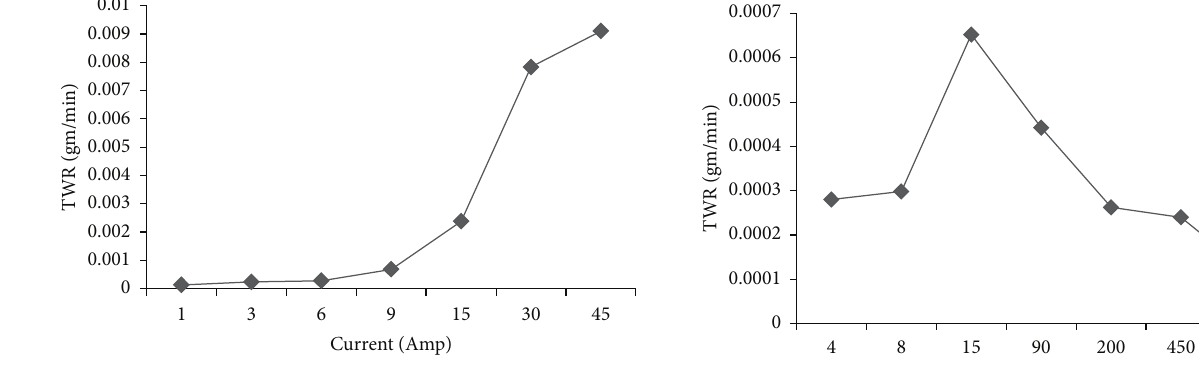
Figure13:InfluenceofcurrentonTWRatconstantgapvoltage60 V, pulse-on time 90 𝜇 s, and pulse-off time 90 𝜇 s.